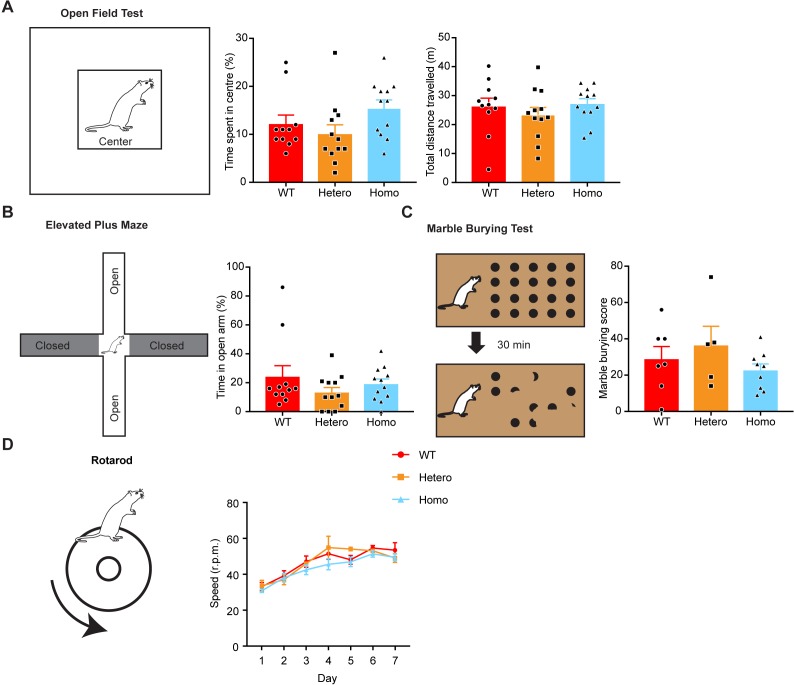
KIF5B conditional knockout mice showed no significant abnormalities in anxiety-related behavior tests.(A) Schematic diagram shows the experimental set-up of open field test and the quantification of time spent in center area and the total distance travelled. n = 11 for WT. n = 12 for Hetero and Homo. Data are presented in mean + SEM, One-way ANOVA and Kruskal-Wallis test. (B) Schematic diagram shows the experimental set-up of elevated plus maze and the quantification of the time spent in open arm. n = 11 for WT. n = 12 for Hetero and Homo. Data are presented in mean + SEM, Kruskal-Wallis test. (C) Schematic diagram shows the experimental set-up of marble burying test and the quantification of marble burying. n = 7 for WT. n = 5 for Hetero. n = 9 for Homo. Data are presented in mean + SEM, One-way ANOVA. (D) Schematic diagram shows the experimental set-up of rotarod and the quantification of performance of mice in seven days of rotarod training. Performance is represented in the highest speed (rate per minute, r.p.m.) the mice achieved before they fell from the rotarod. n = 5 for WT. n = 2 for Hetero. n = 7 for Homo. Data are presented in mean + SEM, Two-way ANOVA.
Figure 8—figure supplement 1—source data 1.Plotted values for Figure 8—figure supplement 1.